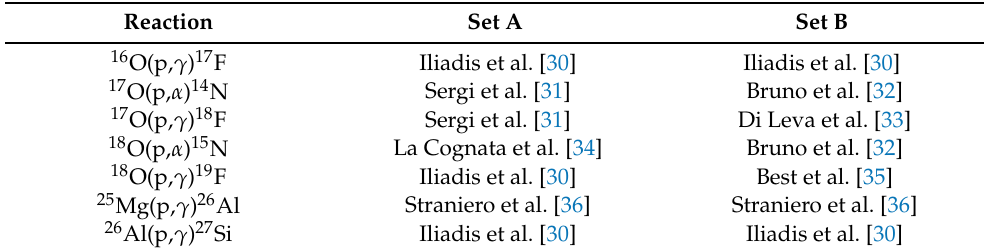
Table 1. Set A and set B of the reaction rates employed in nucleosynthesis calculations.